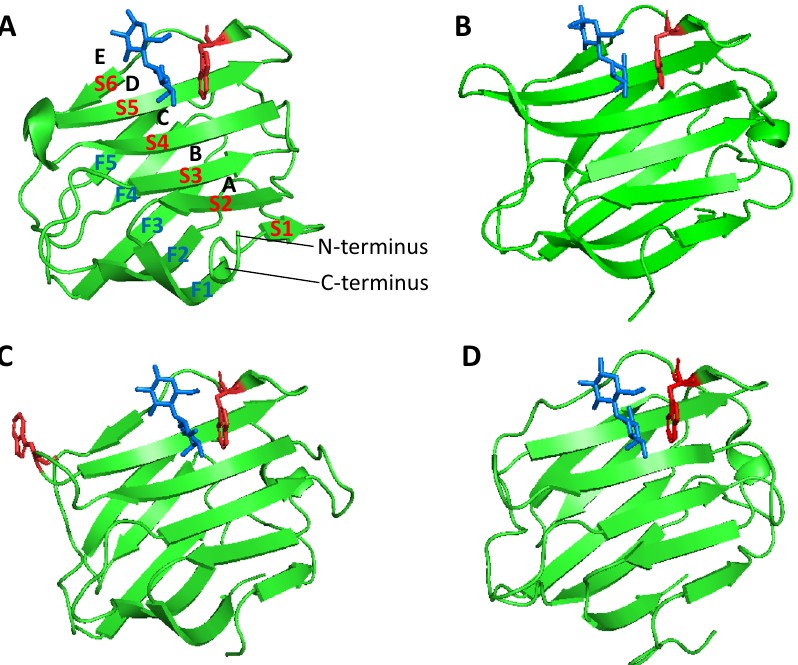
Figure 1. The CRDs of galectins-2, -3 and -4 and tryptophan residues in CRDs. The CRDs of galectin-2 (PDB code: 5DG2) ( A ) galectin-3 (3ZSJ) ( B ) galectin-4N (5DUV) ( C ) and galectin-4C (4YM3) ( D ) are shown as cartoon representations with tryptophan residues (red) and lactose molecules (blue) in stick representations. Galectin-2, galectin-3 and galectin-4C CRDs each contains one tryptophan and galectin-4N contains two tryptophan residues. Galectin binding subsites ( A – E ) strands S1–S6 and F1–F6 in CRD are also indicated in ( A